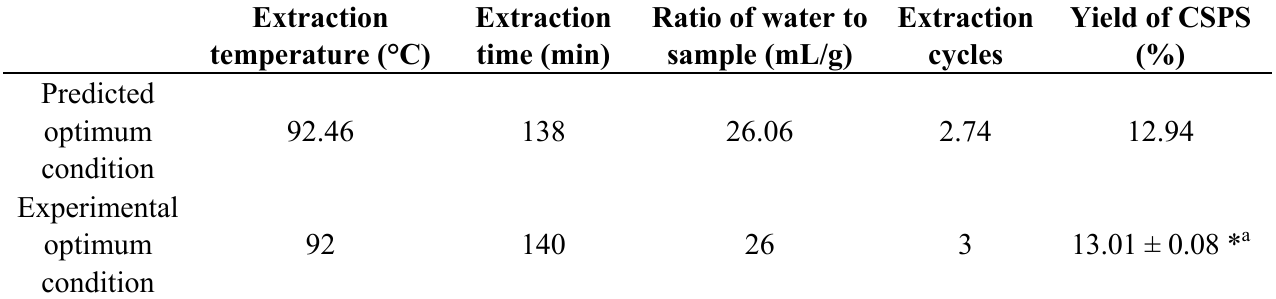
Table 4. Predicted and experimental values of the responses at optimum conditions.